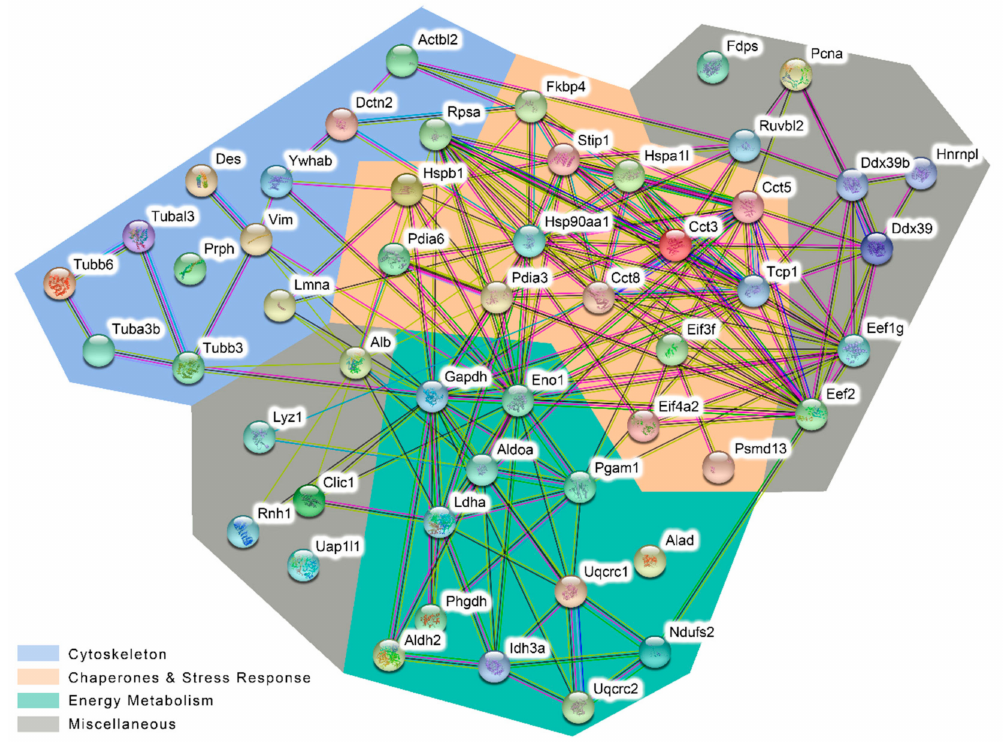
Figure 6. Specific network analysis of HL-1 proteins modified by